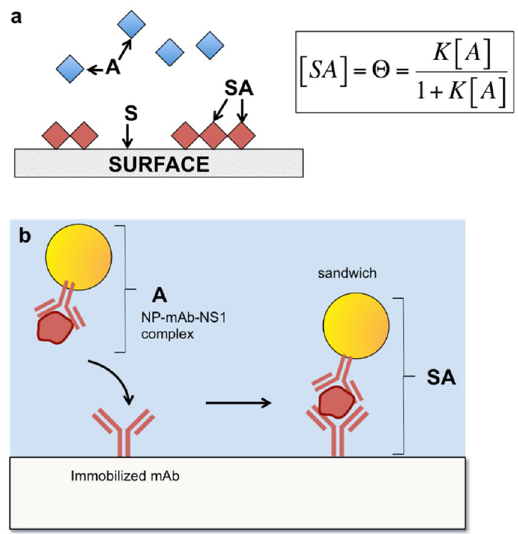
Figure 5. Langmuir binding isotherm adapted to describe the binding event in a sandwich immunoassay. ( a ) Schematic of the free species A adsorbing onto a surface S, forming a surface bound species, SA. ( b ) Analogous schematic with the NP‐Ab conjugate bound to NS1 binding to surface bound antibody on the test line. From Reference [66] .